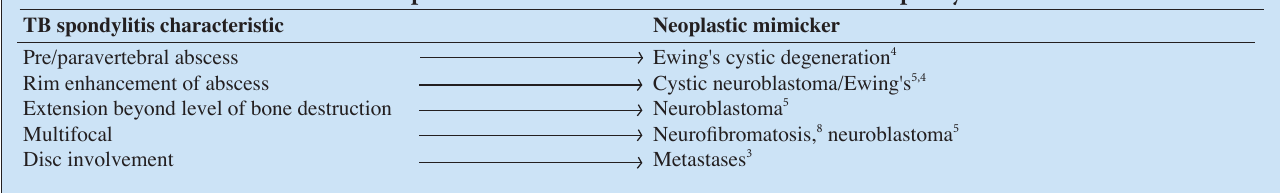
Table II. Neoplastic mimickers of characteristic features of TB